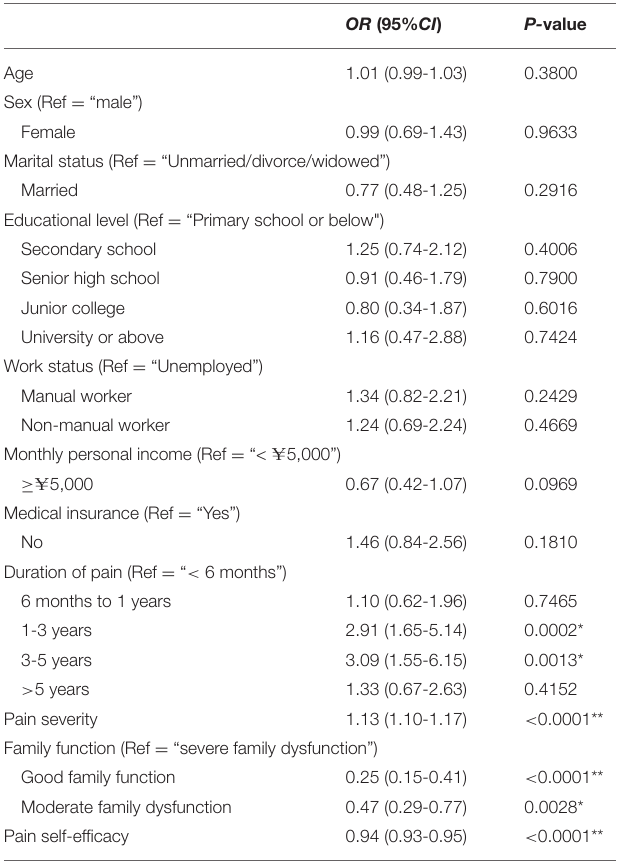
TABLE 2 | Binary Logistic analysis of depressive symptoms related factors in patients with chronic low back